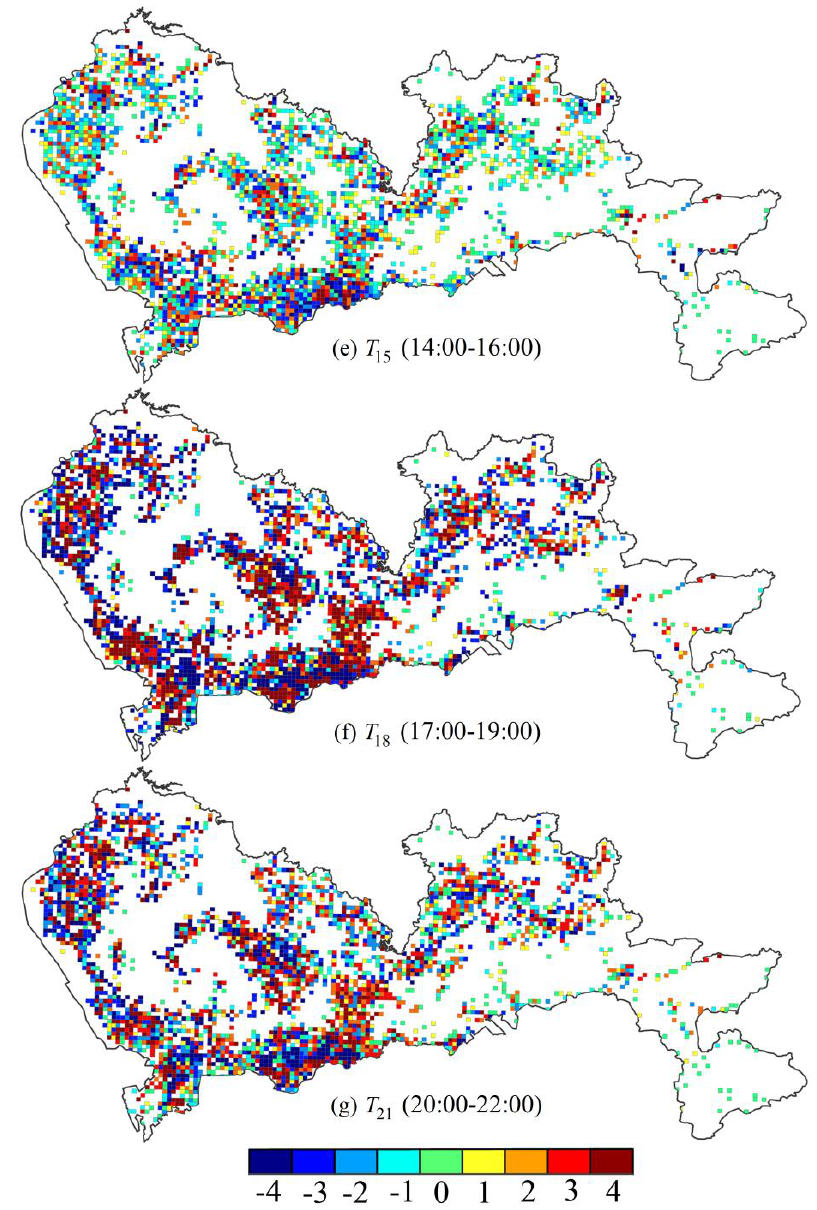
Figure 5. Human convergence and dispersion in selected time slots. ( a ) Spatial distribution of human convergence and divergence during time slot T 3 ; ( b ) Spatial distribution of human convergence and divergence during time slot T 8 ; ( c ) Spatial distribution of human convergence and divergence during time slot T 10 ; ( d ) Spatial distribution of human convergence and divergence during time slot T 12 ; ( e ) Spatial distribution of human convergence and divergence during time slot T 15 ; ( f ) Spatial distribution of human convergence and divergence during time slot T 18 ; ( g ) Spatial distribution of human convergence and divergence during time slot T 21 .